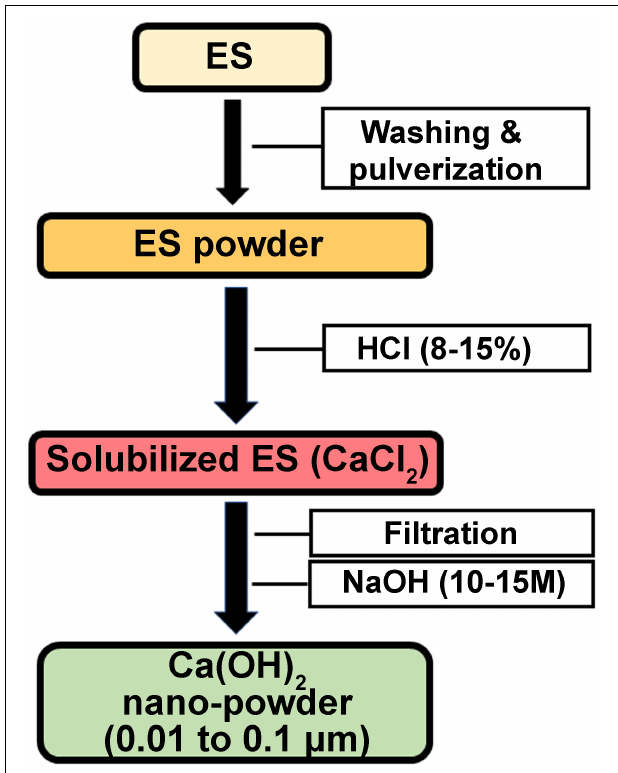
FIGURE 6 | Schematic presentation of patent RO133975A0 describing a method to prepare NPs based on ES-derived Ca(OH) 2 .